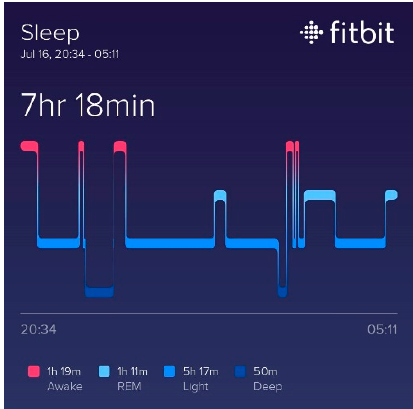
Figure A24. Bangkok,